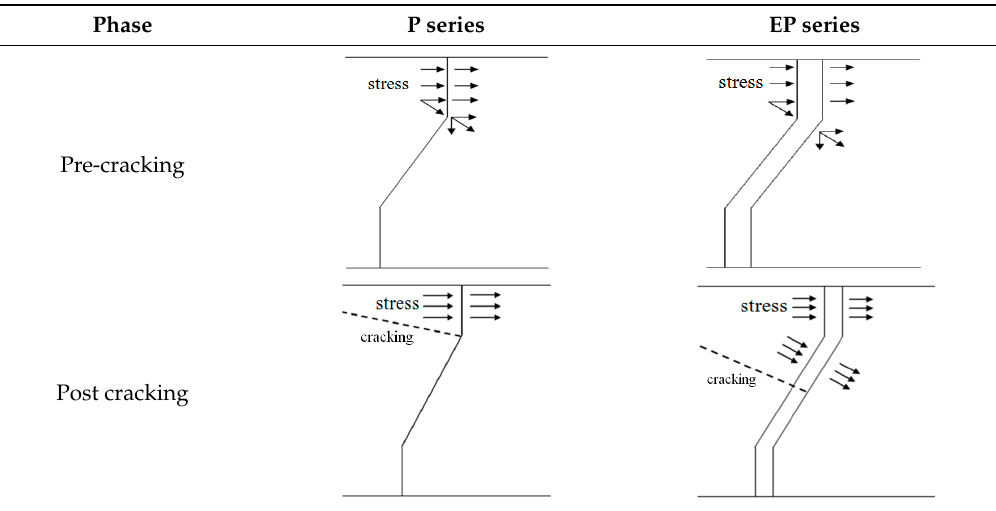
Figure 20. Stress distribution in rebars. ( a ) P series; and ( b ) EP series. Table 12. Change of stress transmission area.